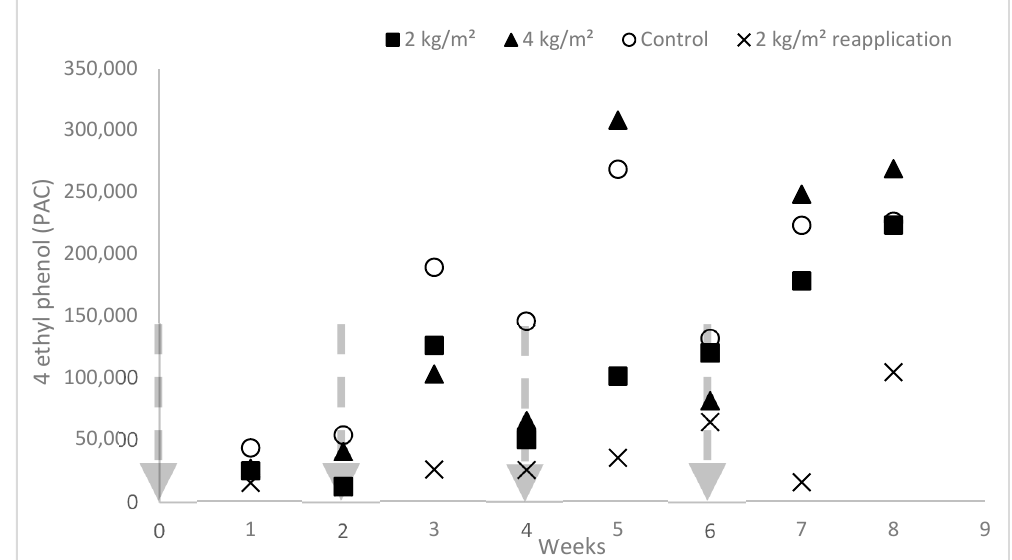
Figure 6. Mitigation of 4-ethyl phenol emissions from swine manure treated with biochar—effects of one-time dose (2 and 4 kg/m 2 ) and 2 kg/m 2 bi-weekly reapplication. Vertical arrows represent the application or reapplication of biochar and manure to storage simulators. Each data point represents the mean of ( n = 3) measurements. Detailed statistical analysis is provided in Table S6. A surrogate abundance of indole is represented by (PAC), i.e., peak area counts for indole in the headspace above manure measured by SPME and analyzed by GC-MS. PACs are arbitrary units of M.S. detector response. In the case of odor (Table 1, Figure S1), no significant mitigation impact was observed. The 2 kg/m 2 bi-weekly reapplication treatment reduced the odor concentration by 22%, whereas 2 kg/m 2 and 4 kg/m 2 showed 11% and 4.2% reductions, respectively (Table 1). All three treatments did not show statistical impacts on odor and GHGs (Figures